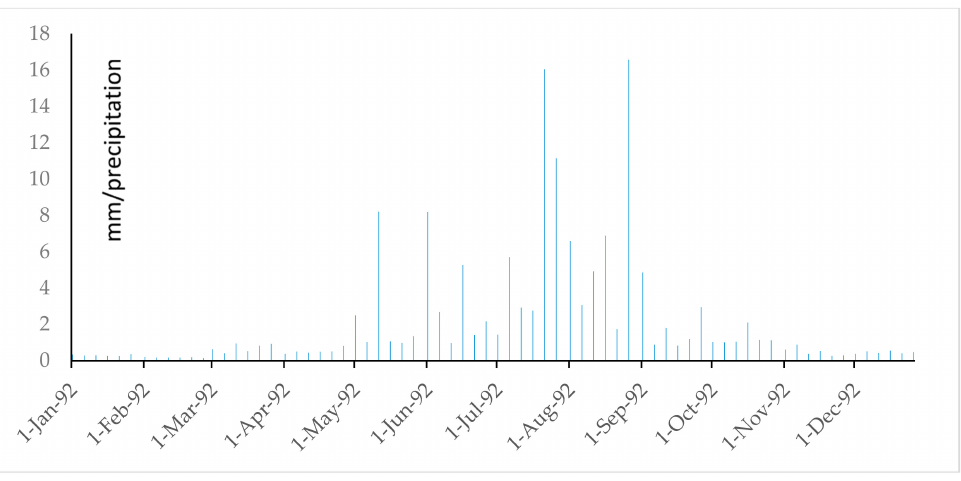
Figure A20. Precipitation of Denko County in 1992.